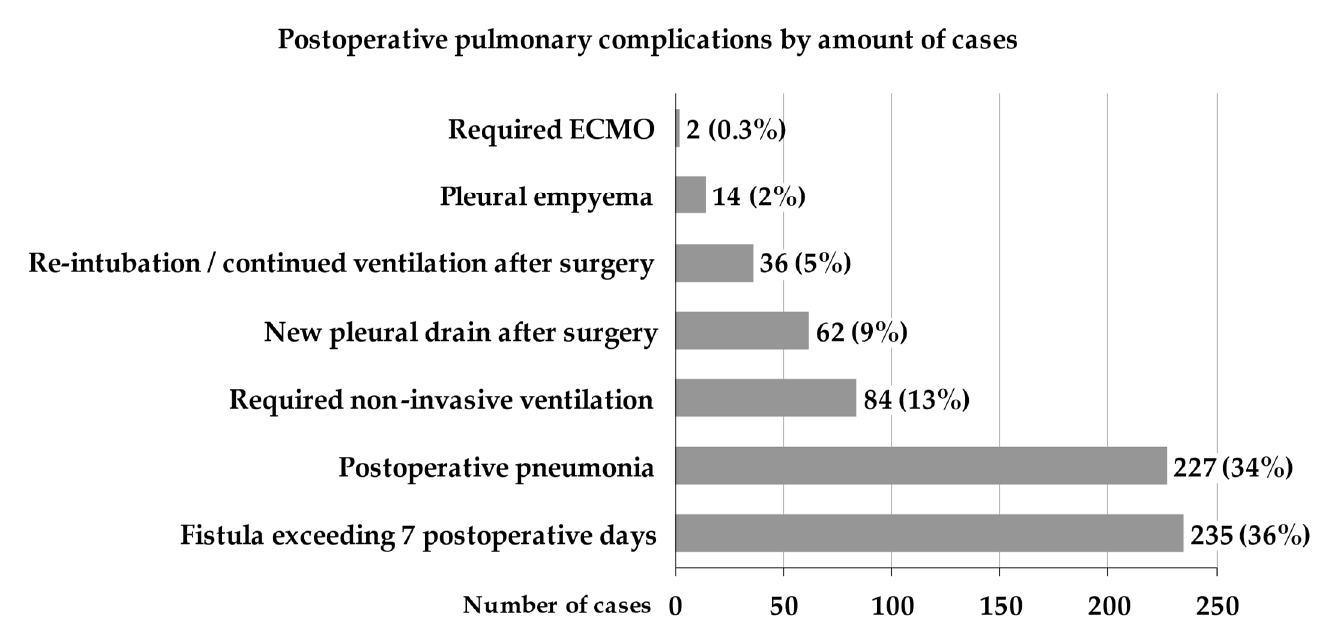
Figure 2. Postoperative pulmonary complications by number of cases. ECMO = extracorporeal membrane oxygenation.